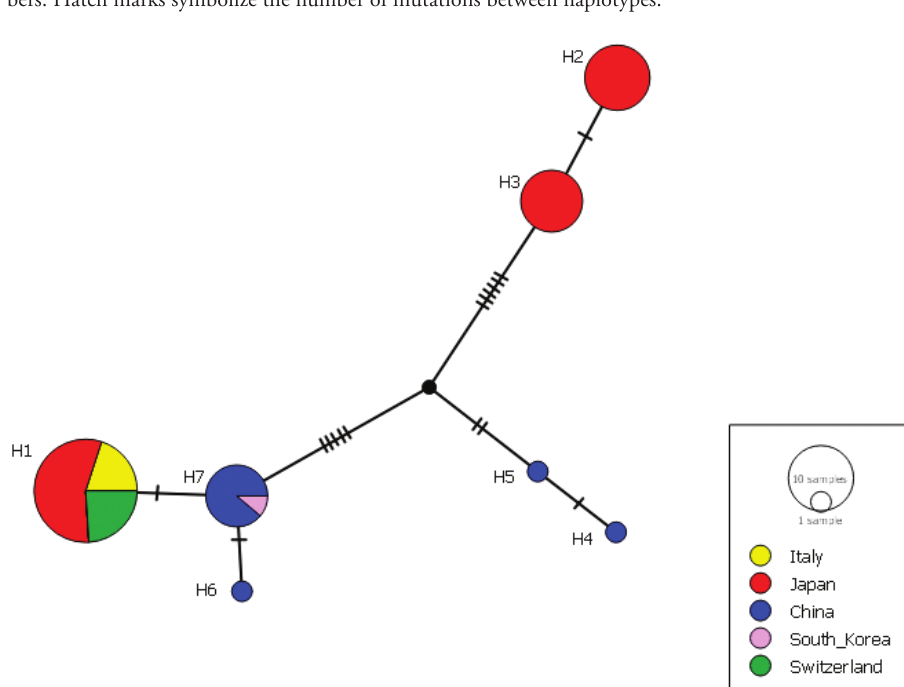
Figure 11. COI haplotype network of the Trissolcus mitsukurii analyzed in this study. Each circle cor- responds to one haplotype; circle size gives the proportion of individuals belonging to the haplotype. The color inside each circle represents the geographical origin. Numbers correspond to the haplotype num- bers. Hatch marks symbolize the number of mutations between haplotypes.